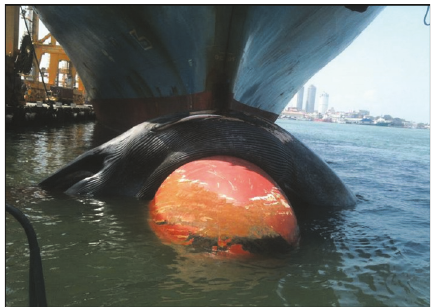
Figure 3: The blue whale draped on the bow of a ship. Photo credit: Sopaka Karunasundara.